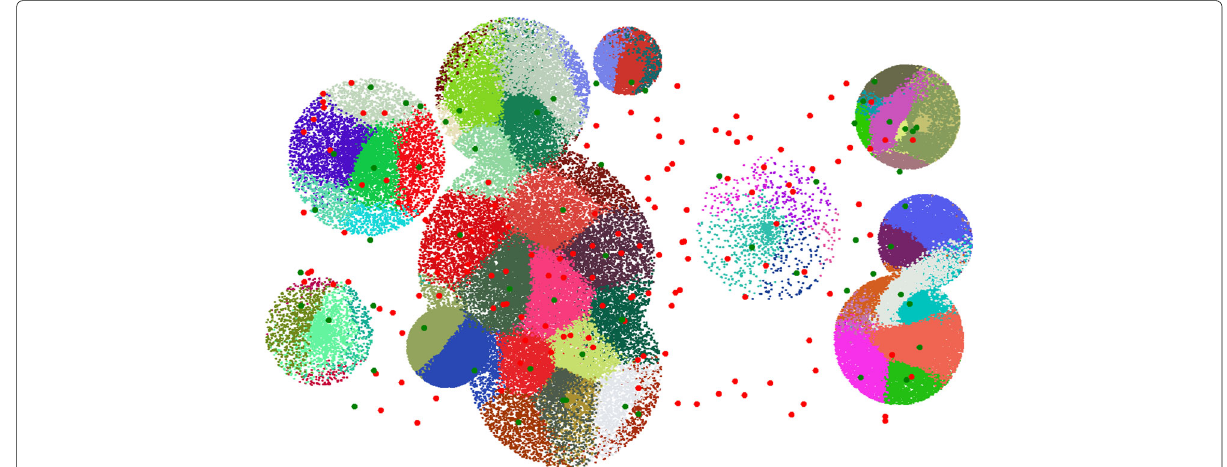
Fig. 2 Visualization of a service topology generated by Swirly. Big red dots are inactive fog nodes, big green dots are active fog nodes servicing nearby edge